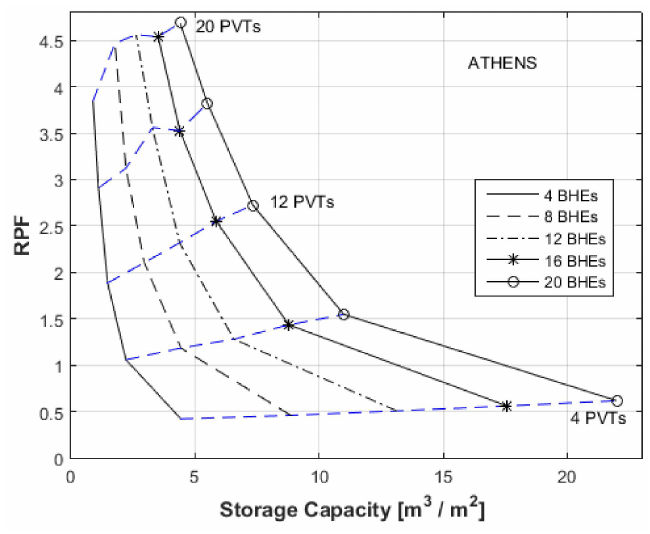
Figure 4. RPF for Athens as function of the storage